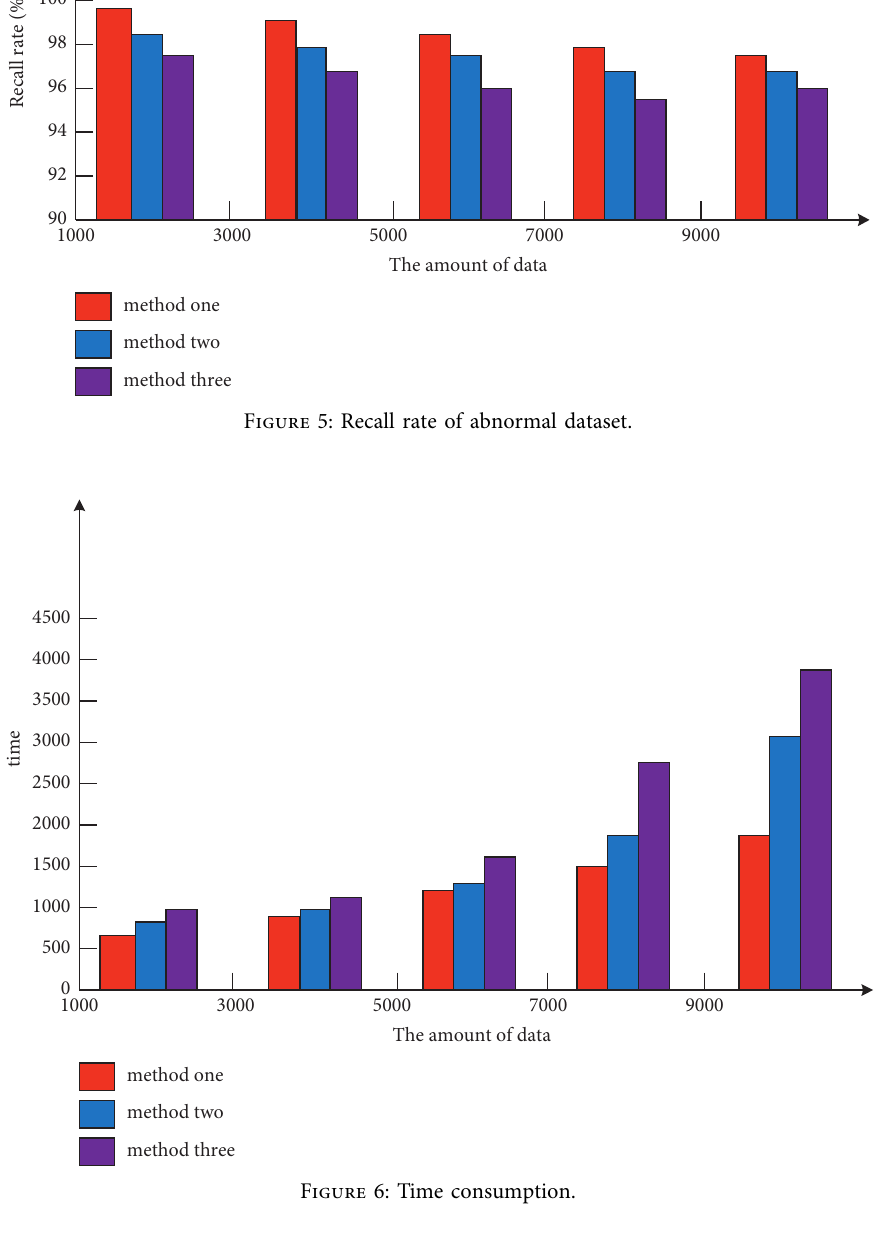
Figure 6: Time consumption.